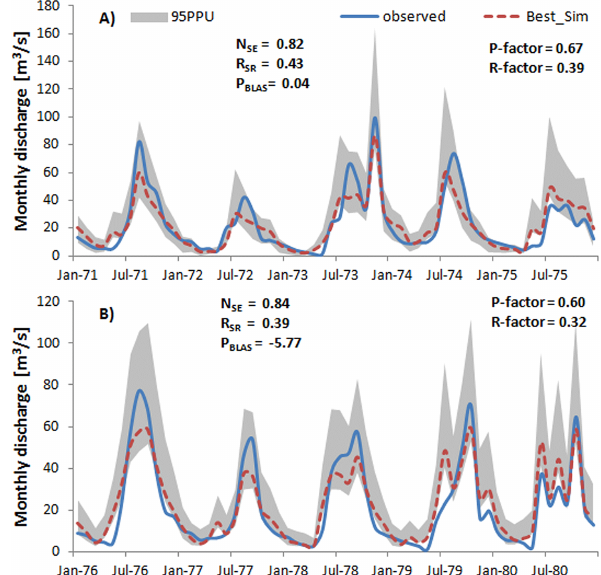
Figure 5. Comparison of the observed monthly discharge (blue bold line) and simulated monthly discharge (red dashed line) with 95% prediction uncertainty band at the Kejie hydrological station. Cali- bration and validation results are shown in Fig. 5a and